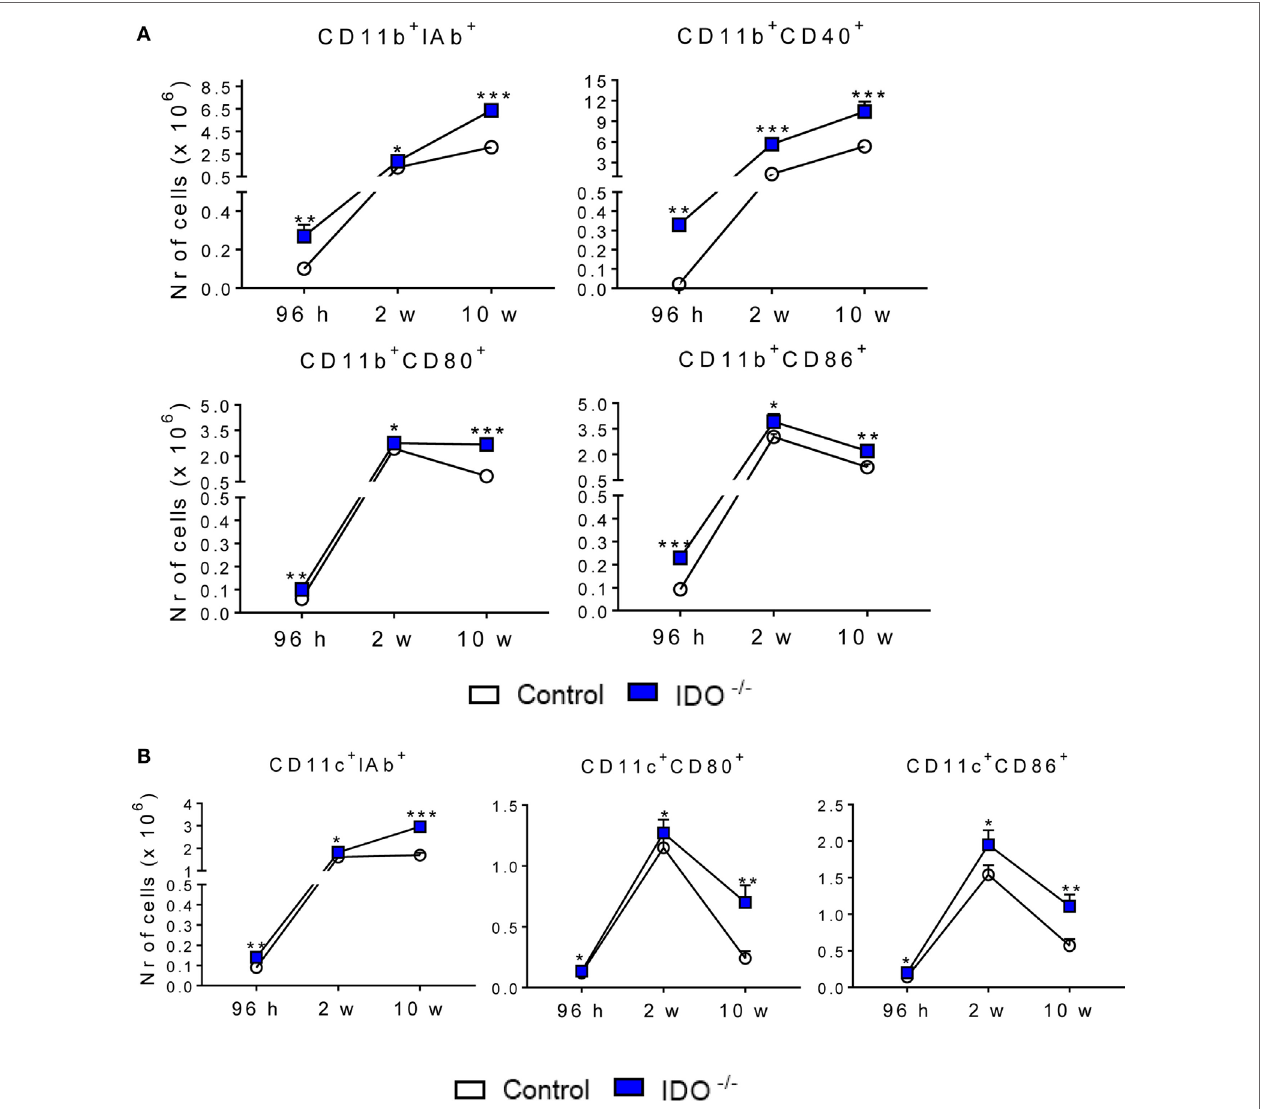
FigUre 3 | Indoleamine 2,3 dioxygenase-1 (IDO1) controls the expression of activation markers of pulmonary CD11b + and CD11c + cells. The activation markers of CD11b + (a) and CD11c + (B) leukocytes were measured in lung infiltrating leukocytes of C57Bl/6 wild-type and IDO1 − / − after 96 h, 2, and 10 weeks of infection with 1 × 10 6 Paracoccidioides brasiliensis yeasts. The lung cells were obtained as described in Section “Materials and Methods” and labeled with antibodies conjugated to different fluorochromes. The lung infiltrating leukocytes were gated by FSC/SSC analysis. The cells were gated for CD11b + or CD11c + expression and then for the presence of IA b , CD40, CD80, and CD86. One hundred thousand cells were acquired on FACS CANTO II and, subsequently, analyzed by FlowJo software. Data are expressed as means ± SEM and are representative of three independent experiments using five mice of each mouse strain per group (* p < 0.05; ** p < 0.01, and *** p <